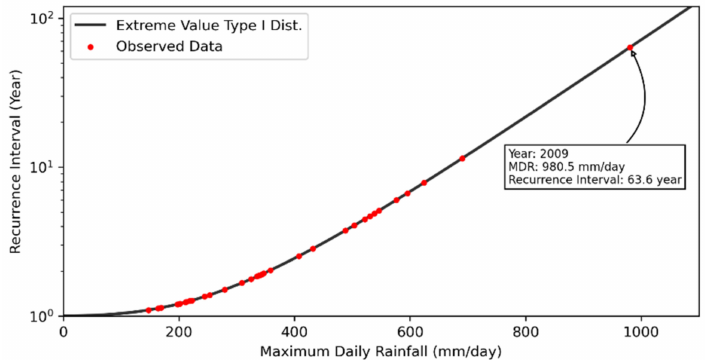
Figure 12. Extreme-value Type I distribution of Longmei rainfall gauge station.